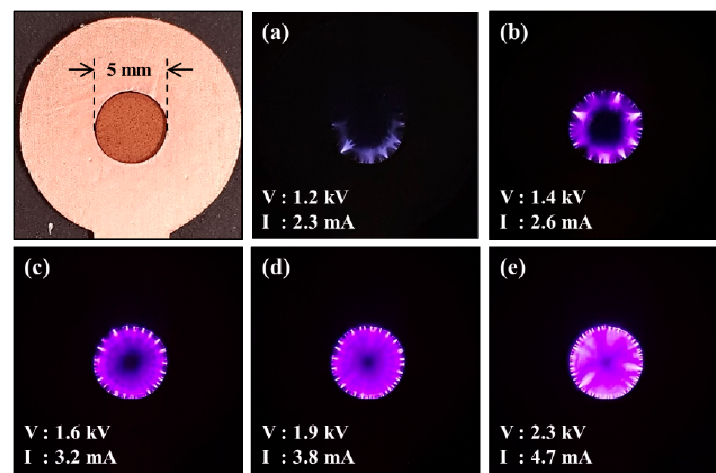
Figure 5. Photographs of the discharge shapes in the dielectric barrier discharge (DBD) structure of Figure 2 in ( a – e ) with the increasing current and voltage on the glass-plate surface.